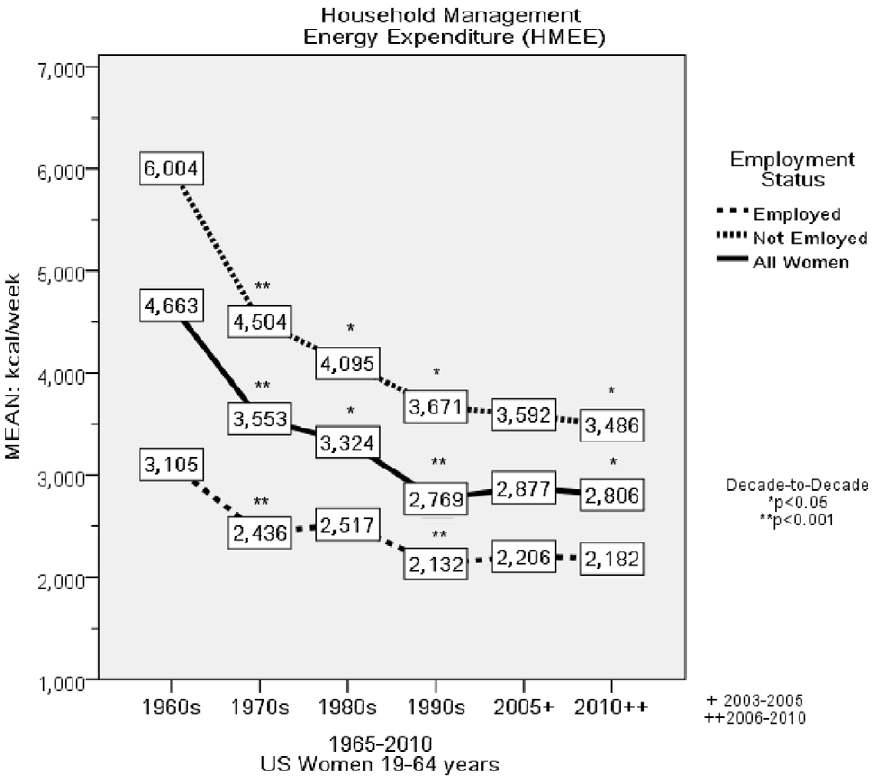
Figure 3. Household Management Energy Expenditure per Week. This figure depicts the decade to decade change in Household Management Energy Expenditure per Week (HMEE/week) for all women and by employment status.